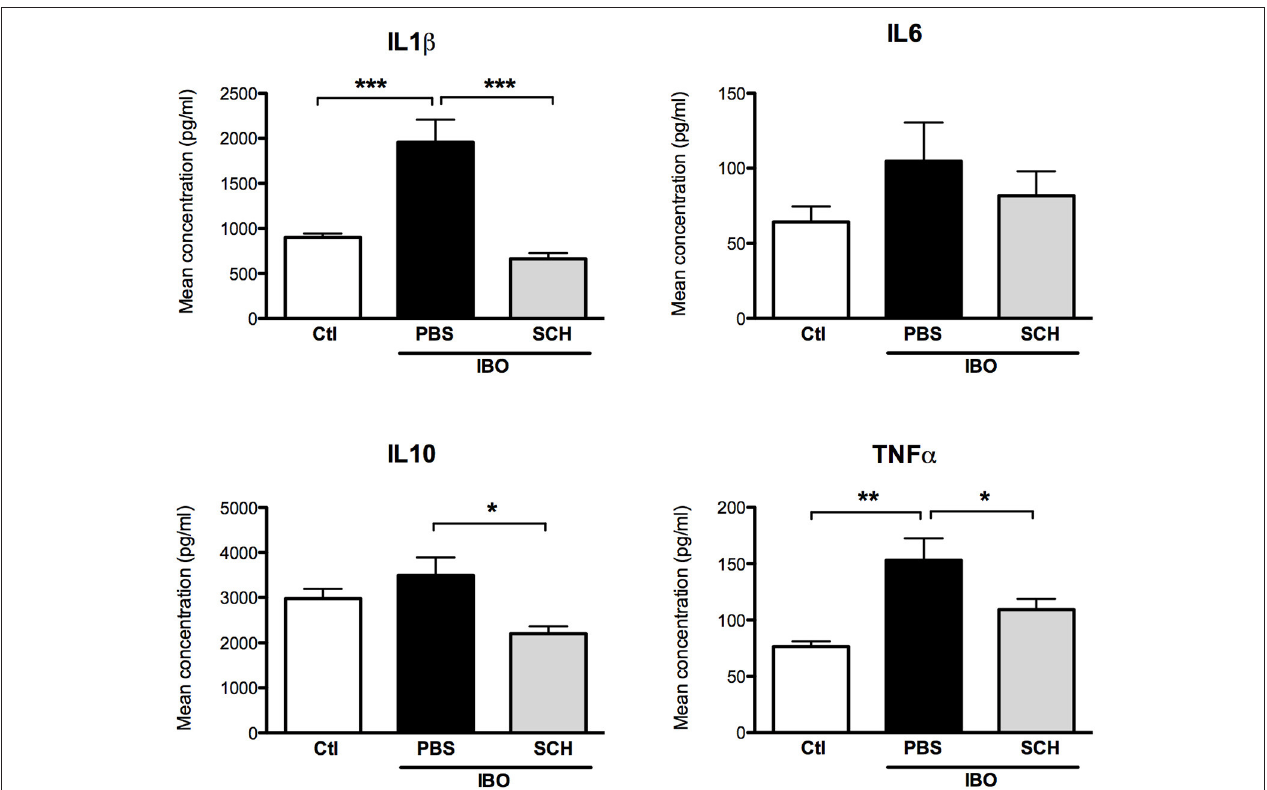
FIGURE 9 | Measurement of cytokine concentrations in culture media collected 12h after 300 µ M ibotenate (IBO) exposure in microglial cells pre-treated with or without SCH. (* p < 0.05, ** p < 0.01, *** p < 0.001, using one-way ANOVA followed by Newman–Keuls post-hoc